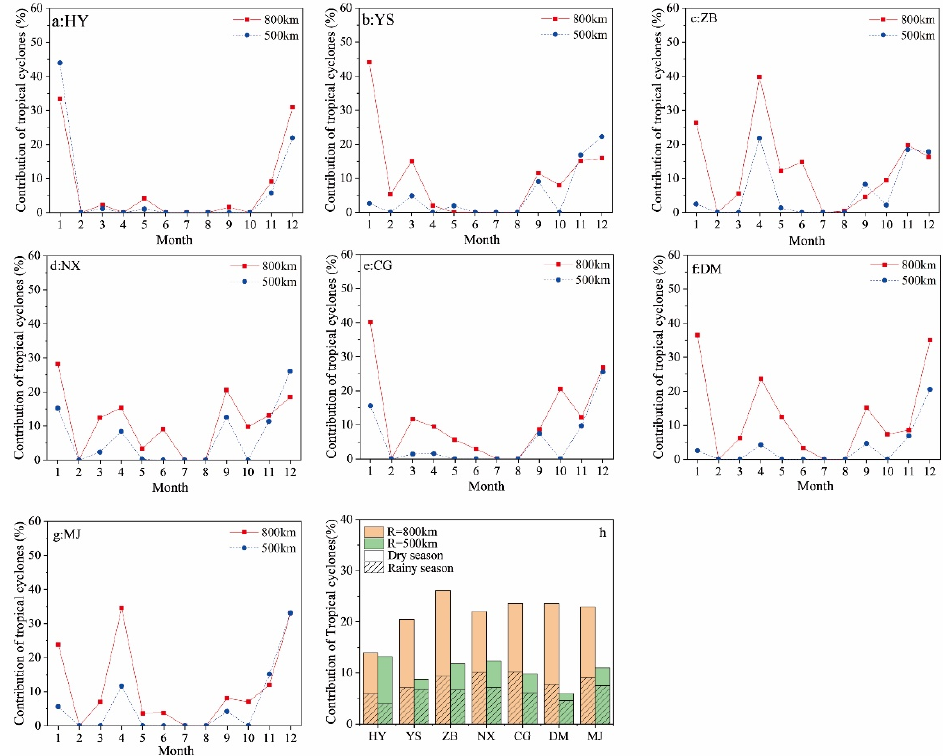
Figure 6. Average monthly ( a – g ) and seasonal ( h ) contribution of TC-induced precipitation.